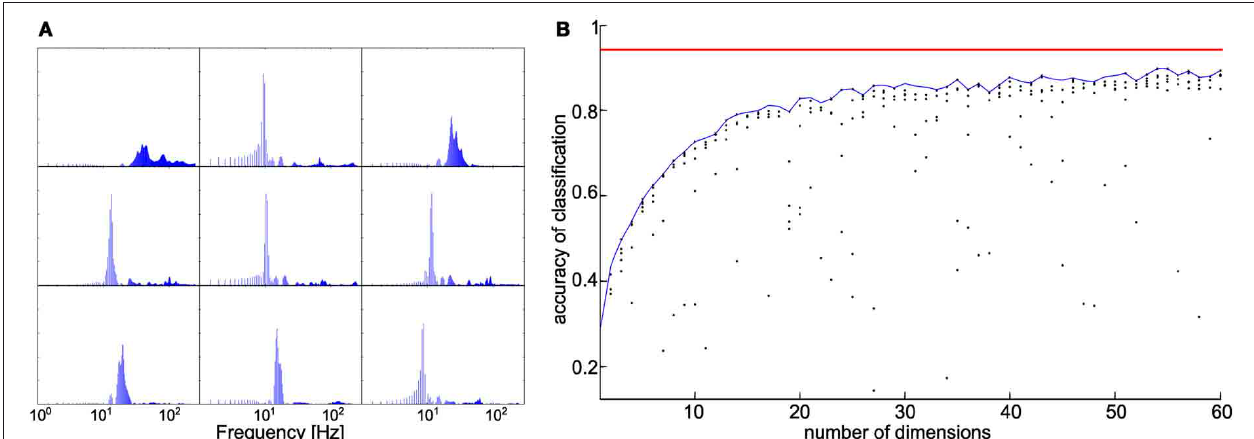
FIGURE 7 | NMF-based dimensionality reduction. (A) Application of non-negative matrix factorization to the FFT spectra of contact signals lead to a set of basis vectors that could be interpreted as different band-pass filters. The nine frequency spectra correspond to the set of optimal filter characteristics when setting the dimension of the NMF-derived vector